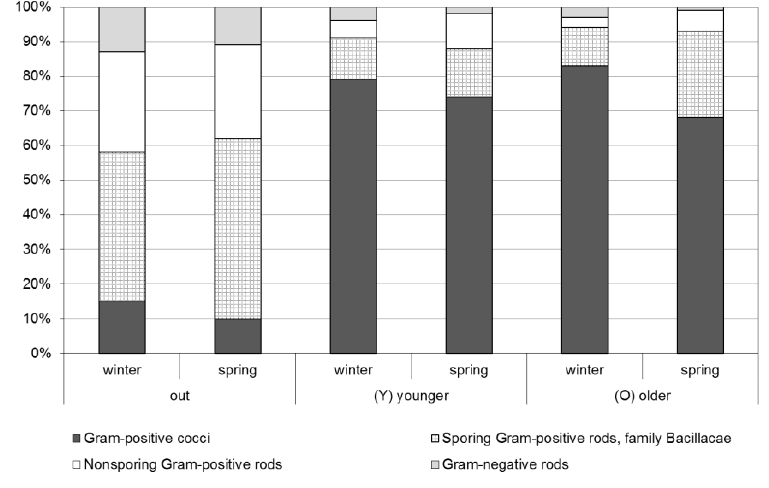
Figure 4. The average percentage of main groups of bacteria isolated from the outdoor and indoor air during winter and spring seasons.